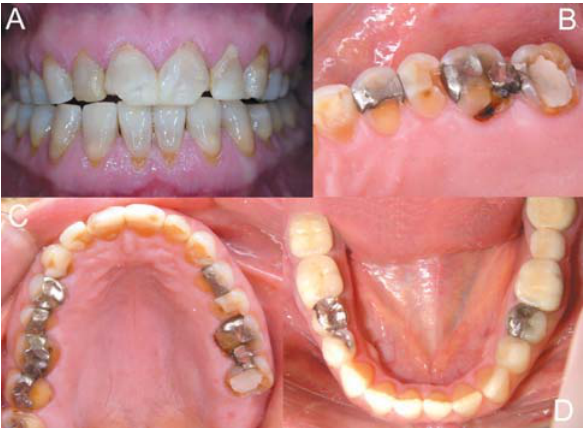
FIGURE 2- Occlusal splint. A: front view, recovering vertical dimension of occlusion; B: anterior guidance; C: left lateral guidance; D: right lateral guidance